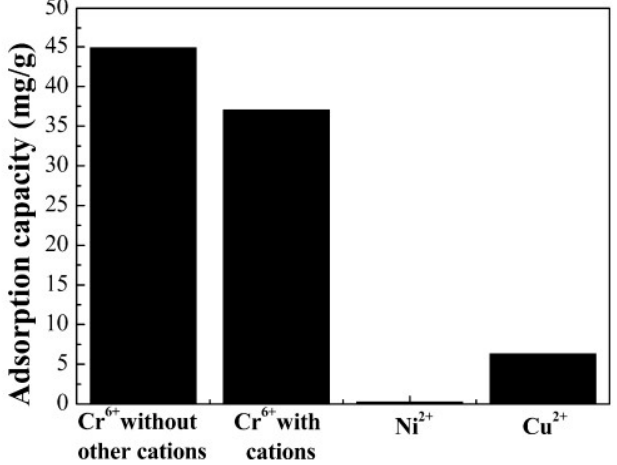
Figure 10. Effect of coexisting ions on adsorption capacities of PAN/PPy nanofiber mat for Cr 6+ , Ni 2+ , and Cu 2+ . Adapted with permission from reference [77].